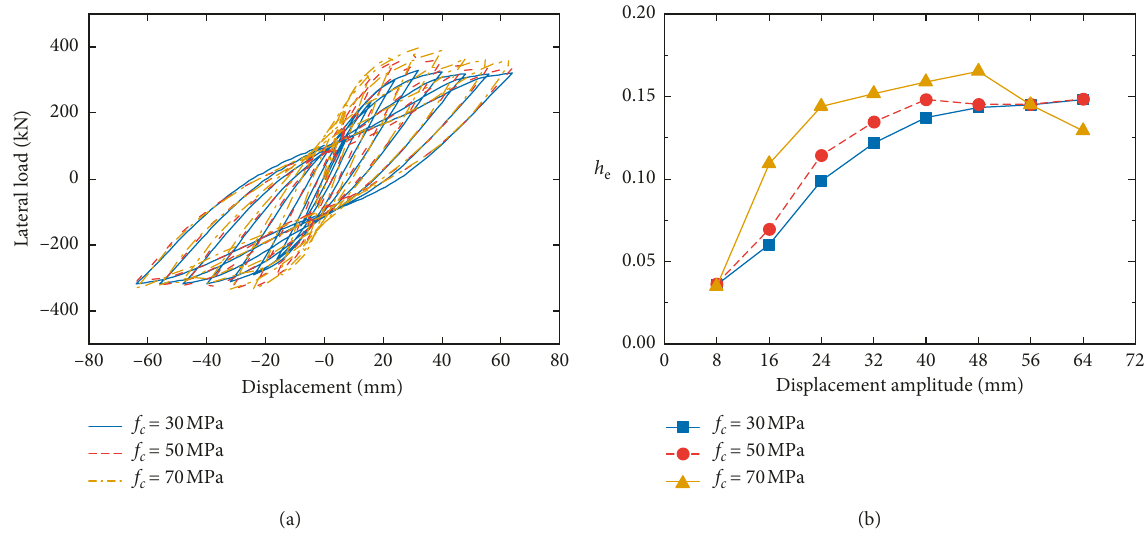
Figure 23: Effect of concrete strength. (a) Hysteresis curves. (b) Equivalent viscous damping